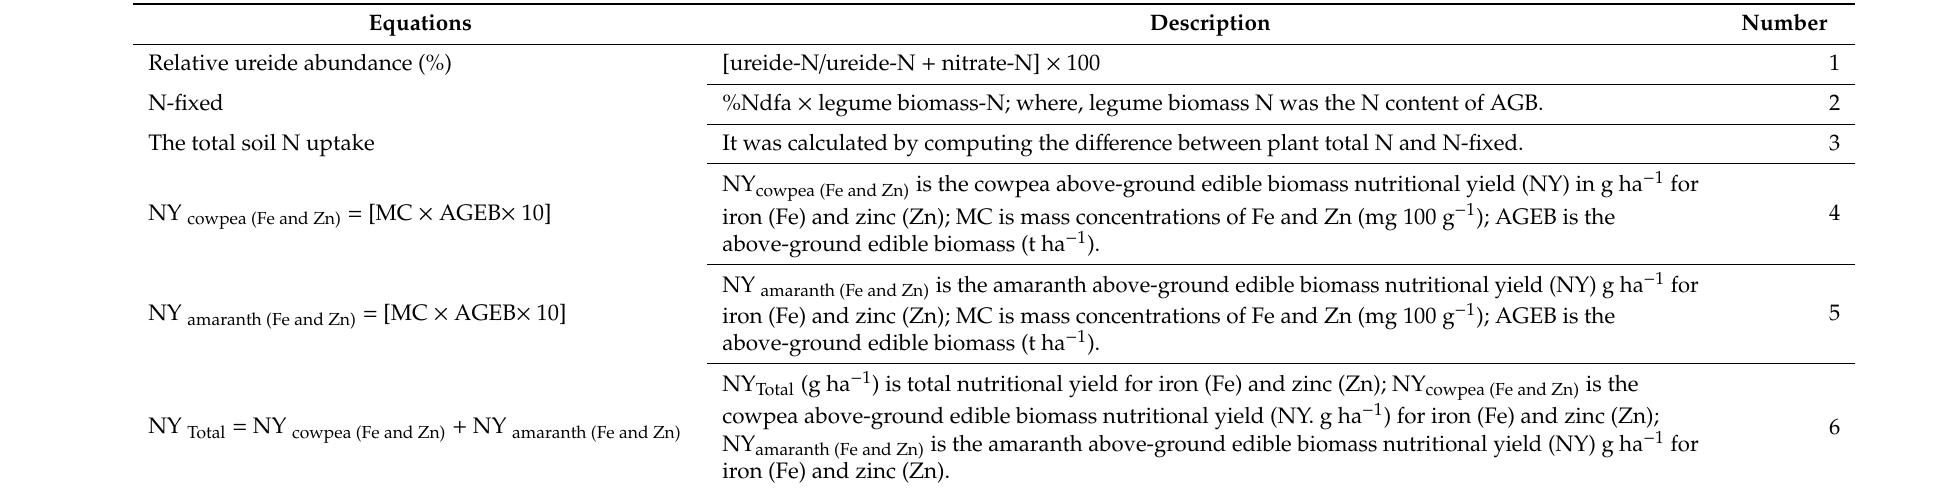
Table 1. Equations utilised to compute selected